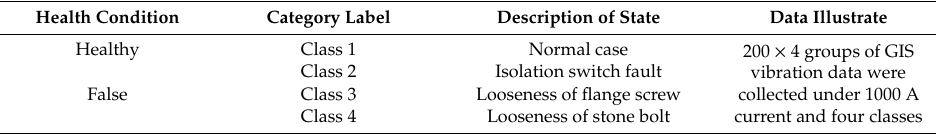
Table 2. Summary of states of gas insulated switchgear (GIS) considered in this study.